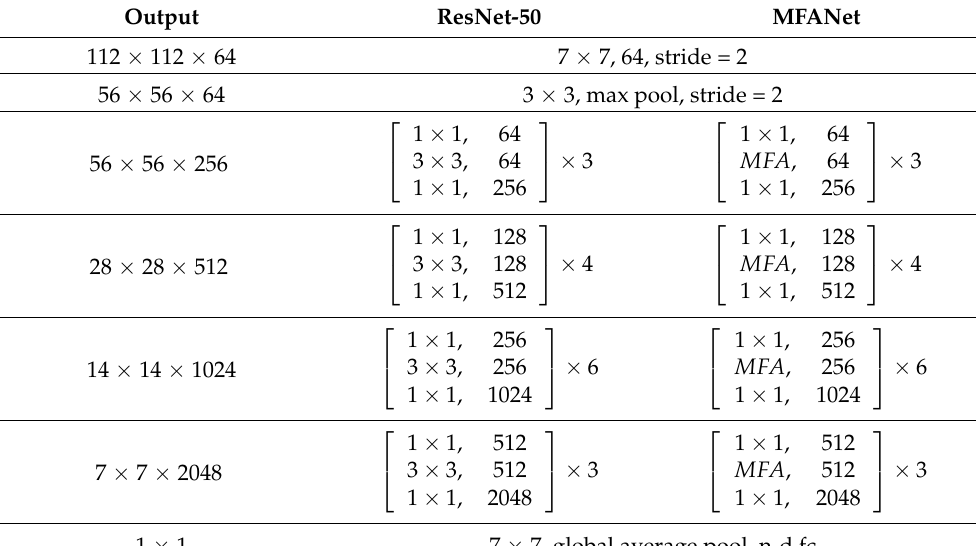
Table 2. MFANET network